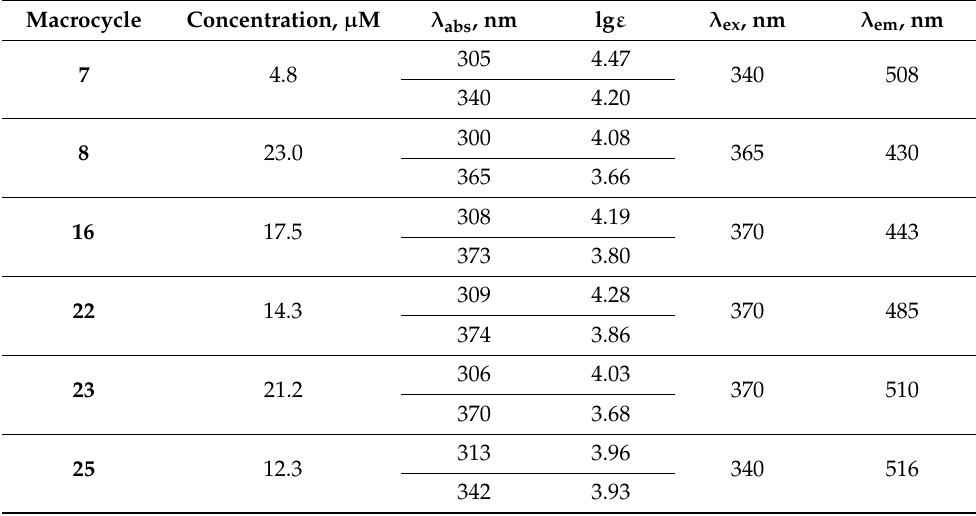
Table 1. Spectroscopic properties of the macrocycles 7 , 8 , 16 , 22 , 23 and 25